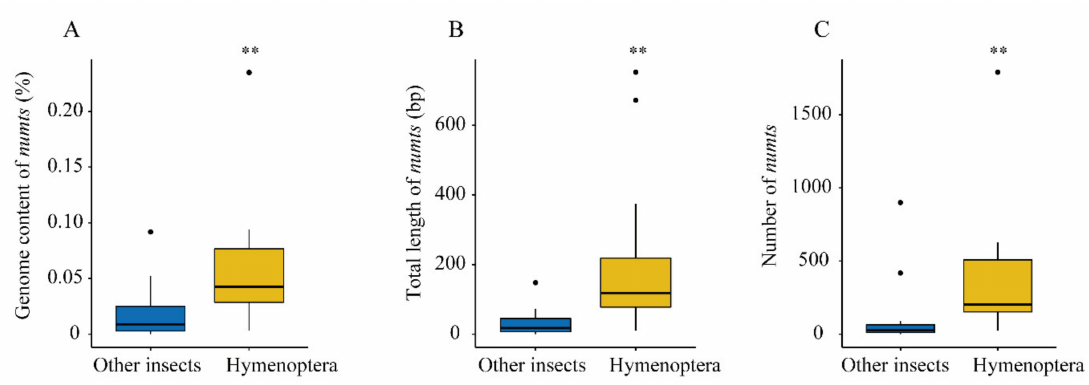
Figure 6. Comparison of NUMTs in Hymenoptera and other insects (Diptera, Lepidoptera, and Coleoptera). The content of NUMTs in the genomes ( A ), the total length of NUMTs ( B ), and the number of NUMTs ( C ) are compared. ** p < 0.01, Wilcoxon